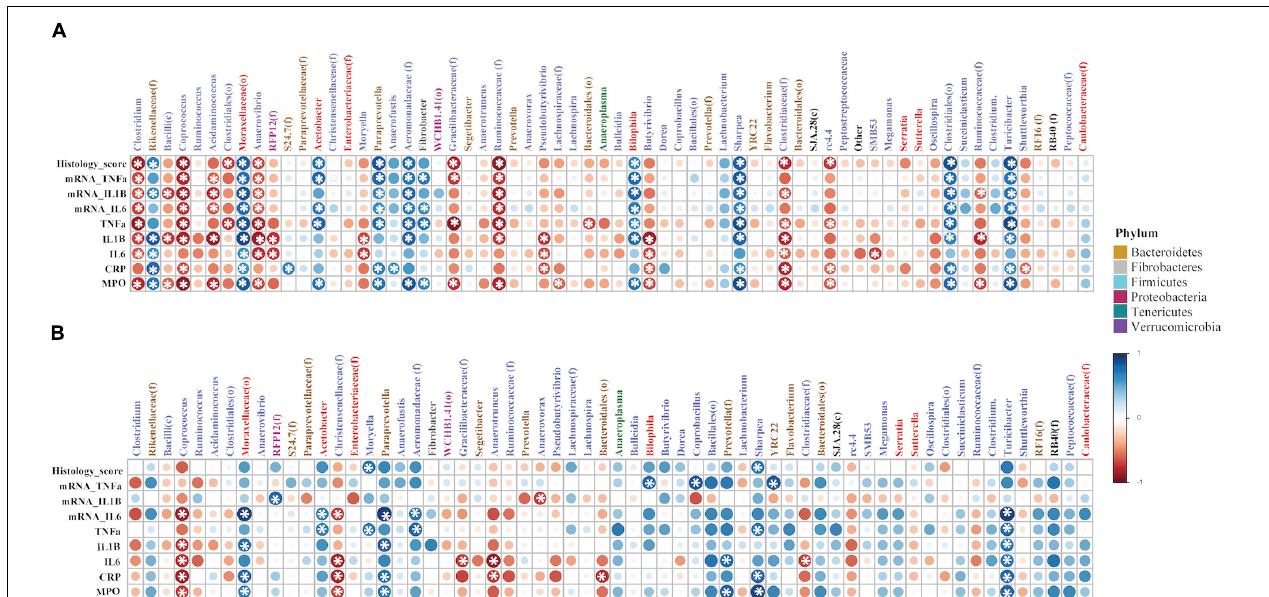
FIGURE 8 | The correlation coefficient between the proportion of abundant colonic bacteria taxa ( ≥ 0.5% of community) and immunological factors (inflammatory markers), in both vehicle and denosumab-treated mice. The non-parametric Spearman’s rank correlation implemented in PAST software was used. For each correlation, correlation coefficient (Spearman’s Rho) and p-value were obtained and the resulting correlation matrix was visualized in a heatmap format generated by the corrplot package of R ver. 02-0.2010. The correlation coefficient values ranged from -1 (red) to +1 (blue) with larger absolute values indicating stronger relationship while positive and negative values between (A) DNBS/Ethanol vs. Ethanol 30% and immunological factors indicating the direction of association and (B) in the presence of denosumab. Alpha value for the correlation confidence intervals was set up as 0.05. * p <